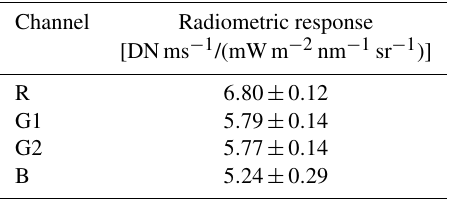
Table 2. HaloCam RAW absolute radiometric response within a 1 σ confidence interval.